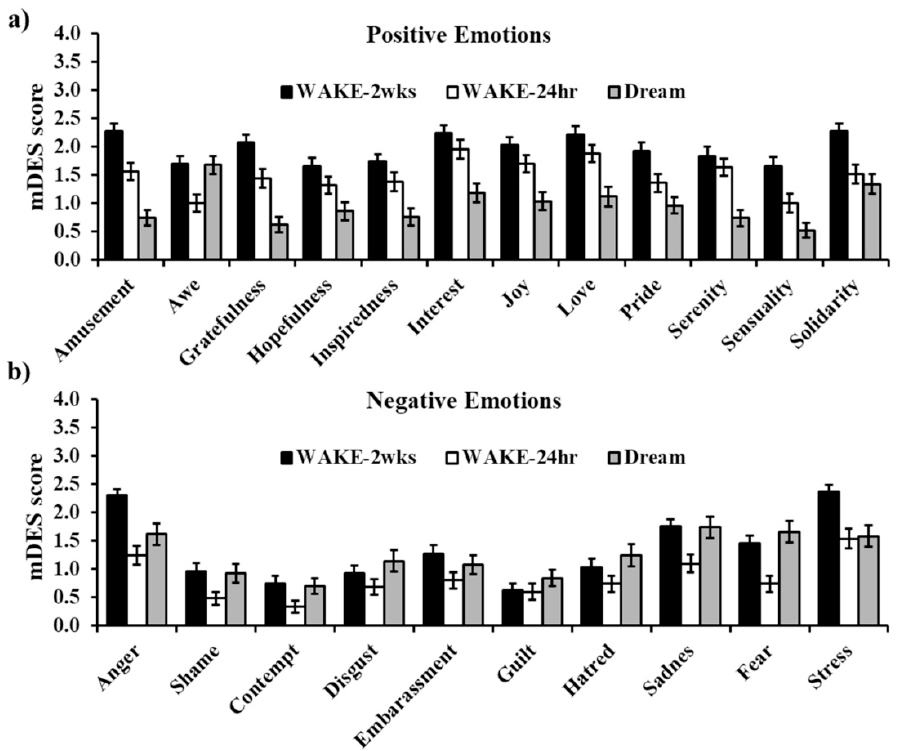
Figure 2. Scores of the 22 emotions in the WAKE-2wks, WAKE-24hr, and Dream mDES. ( a ) and ( b ) display positive and negative emotions, respectively. Error bars represent standard error of the means.